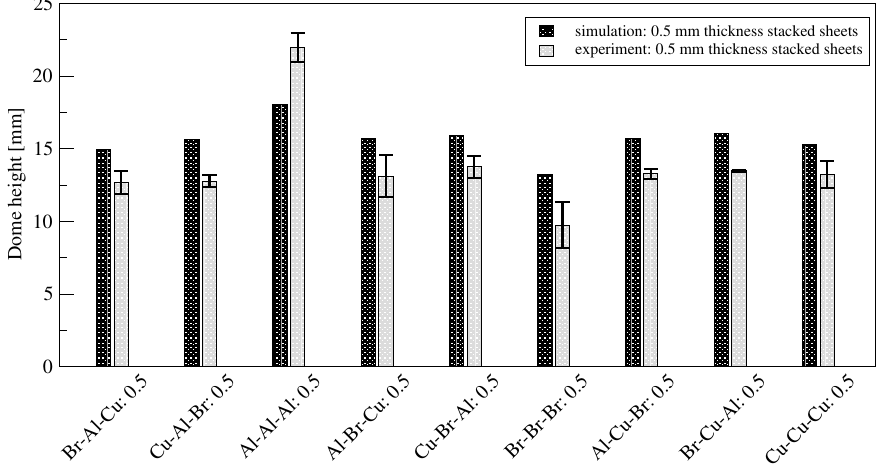
Figure 8. Comparison of dome height of a deformed metal in the experiment and numerical simulation for 0.5 mm thickness